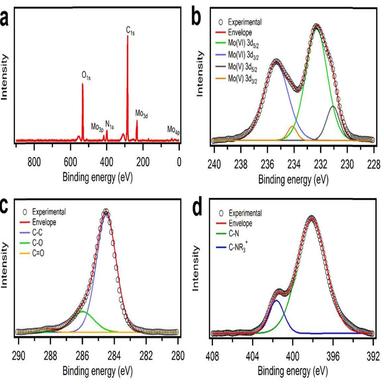
XPS spectra of Mo132-DTAB-EEG: (a) wide range survey, and high-resolution (b)Mo 3d, (c) C 1s and (d) N 1s.